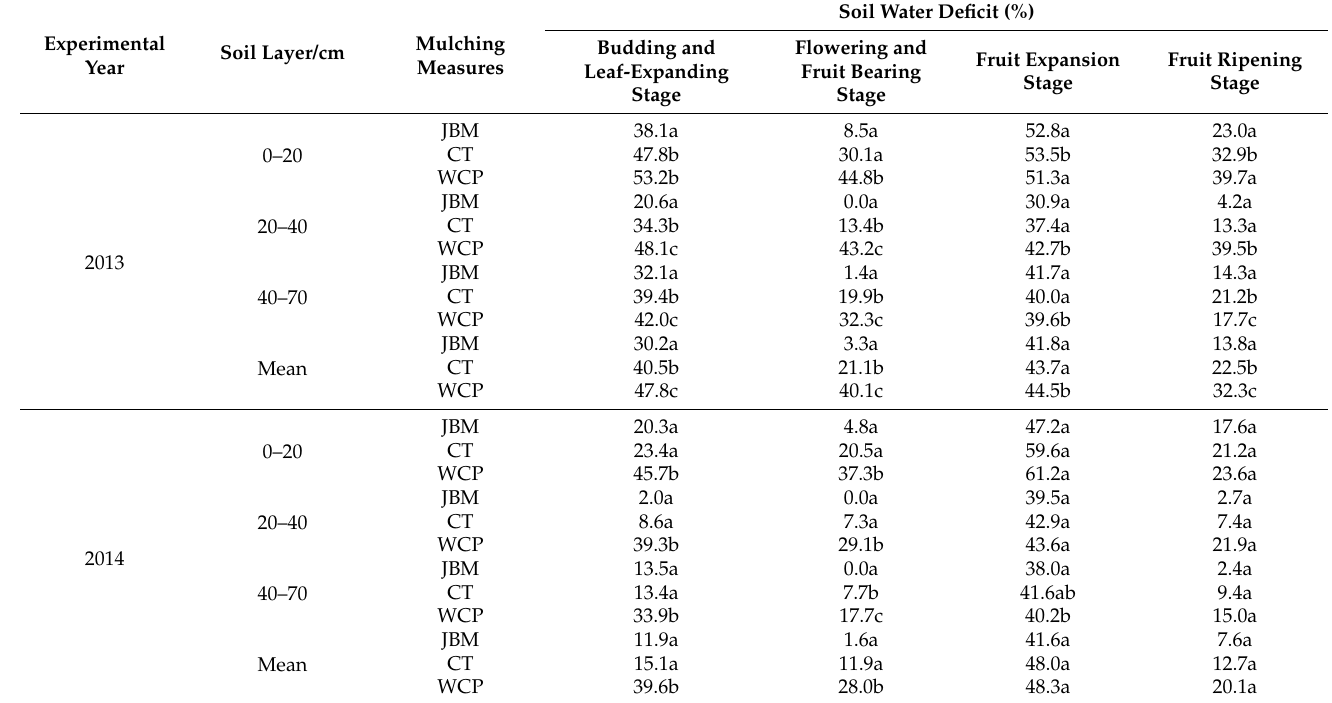
Table 1. Soil water deficit in the 0–70 cm soil layer at each growth stage of jujube under different mulching